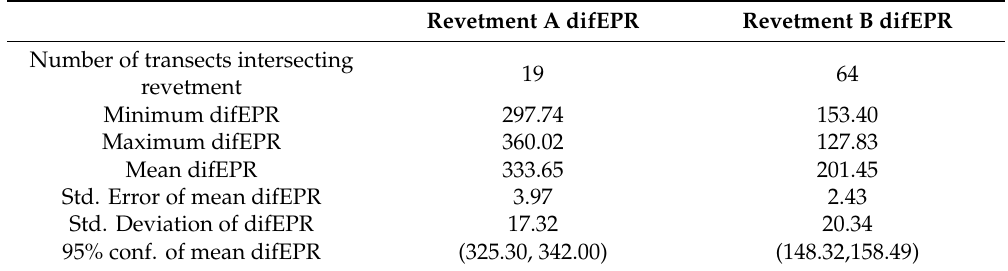
Table 9. Change in EPR (difEPR) m / y for periods before / after revetment installation, m /